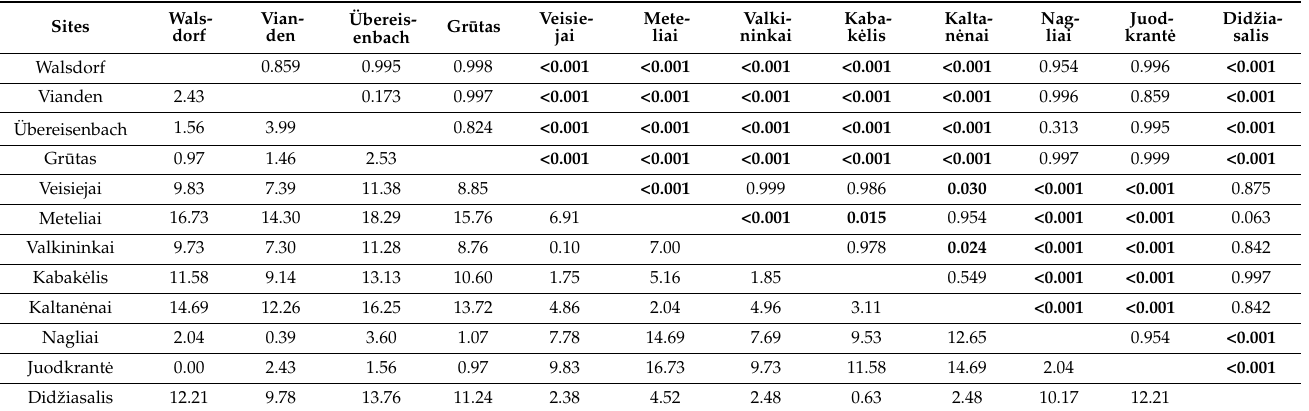
Table A2. Results of pairwise comparisons of the number of ovules between sites using Tukey’s post-hoc test.